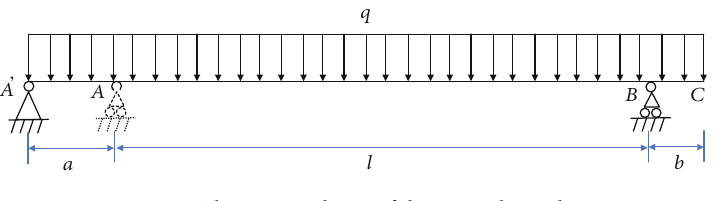
Figure 7: The structural unit of the antioutburst